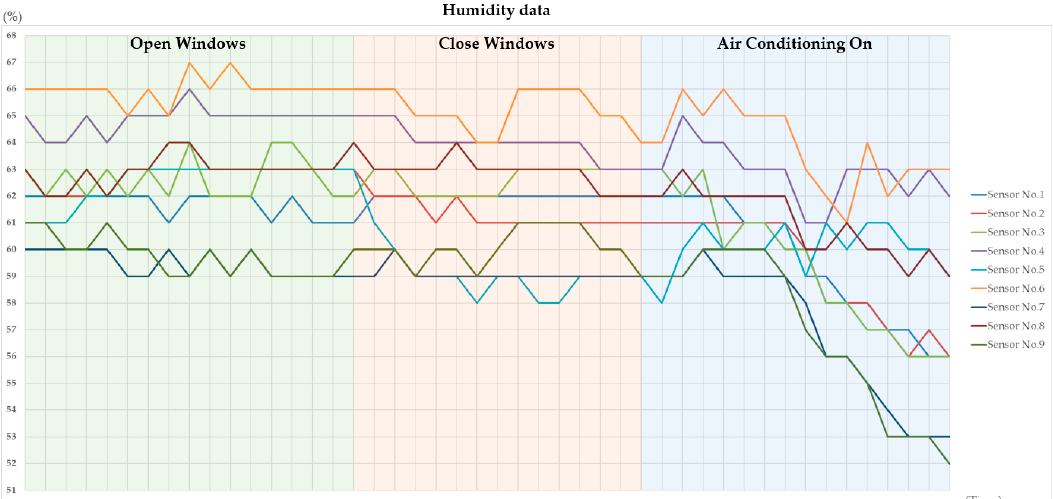
Figure 16. Humidity data for sensors 1–9.